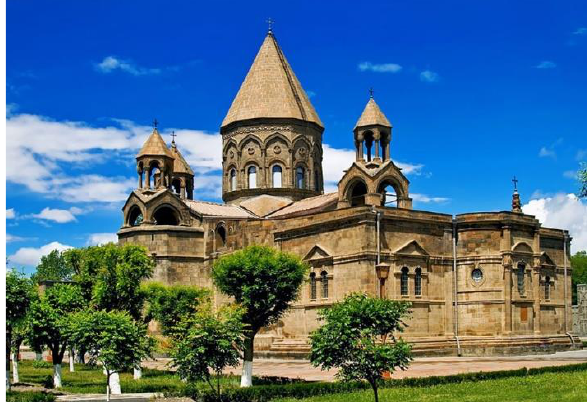
Figure 2. Cathedral of Echmiatsin. ©Vigen Hakhverdyan n.d.